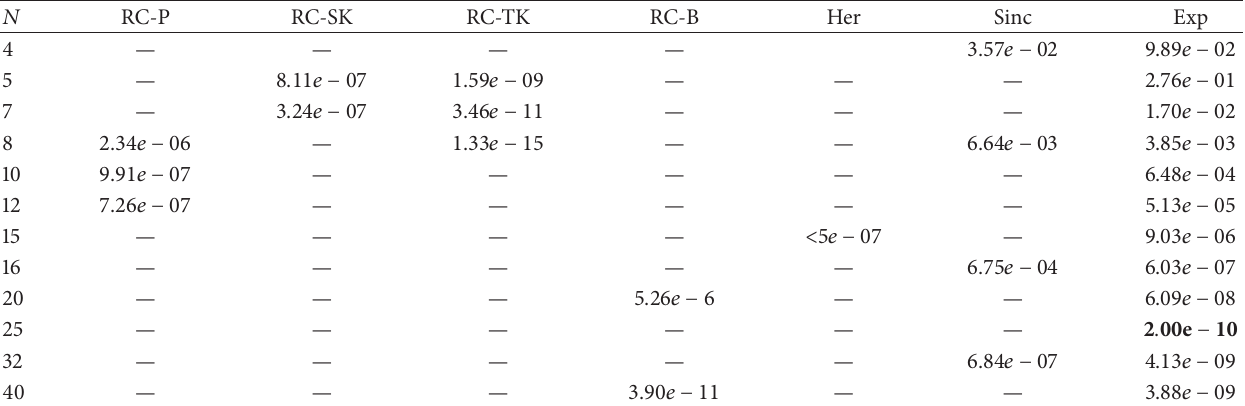
Table 1: Comparison of the effectiveness of the application of spectral methods based on different basis sets for calculating the initial slope 𝑦 󸀠 (0) of the TF equation. 𝑁 RC-P